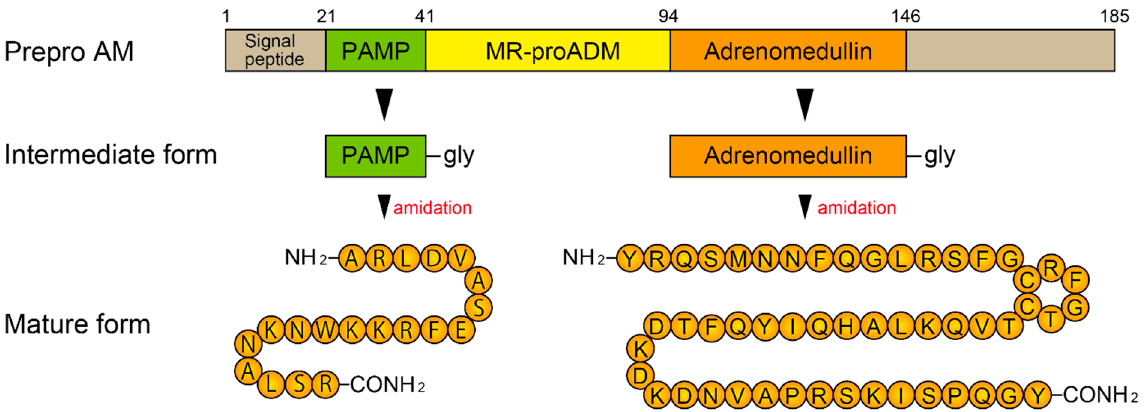
Figure 2. Biosynthesis of adrenomedullin. AM: adrenomedullin; PAMP: pro-adrenomedullin N-terminal 20 peptide; MR-proADM: mid-regional pro-adrenomedullin .